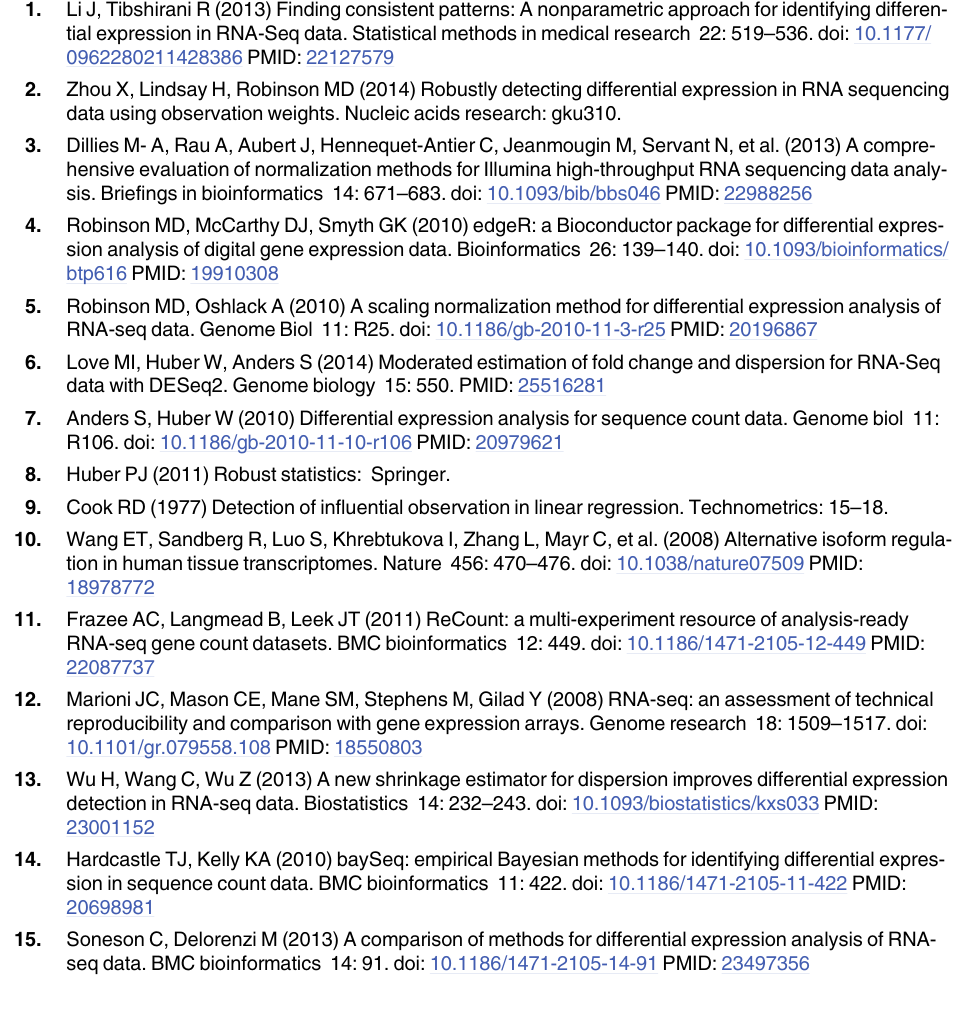
S2 Table. Mean (standard deviation) of accuracy metrics for simulated RNA-seq data com- paring iLOO (using DESeq2 normalized read counts) to DESeq2. Summary statistics for total accuracy, outlier accuracy, and non-outlier accuracy are provided for the simulation study comparing iLOO (using DESeq2 normalized read counts) to DESeq2 . A full simulation study was carried out for each sample size setting consisting of 5, 10, 15, 20, 30, and 40 replicates.